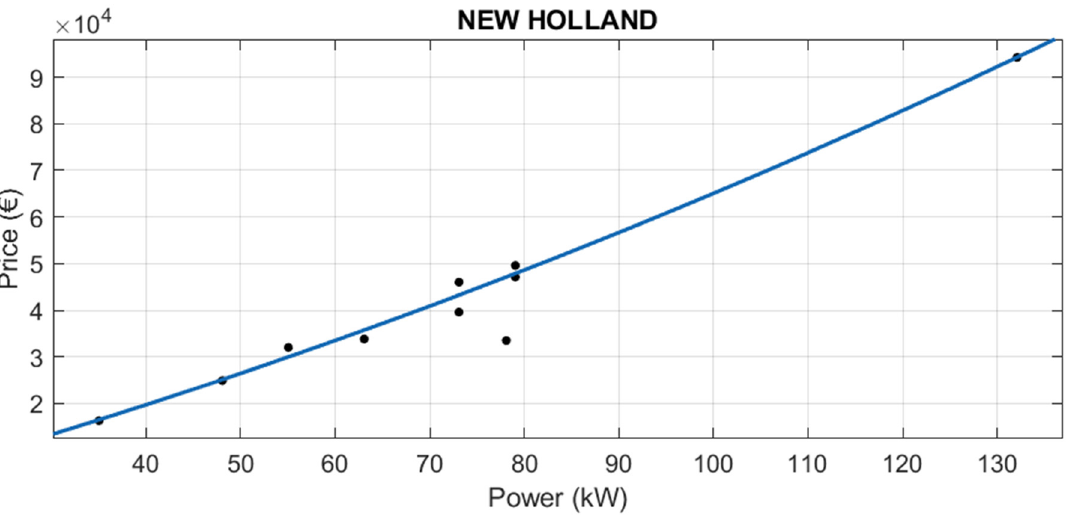
Figure 11. Price vs. power for New Holland new tractors.